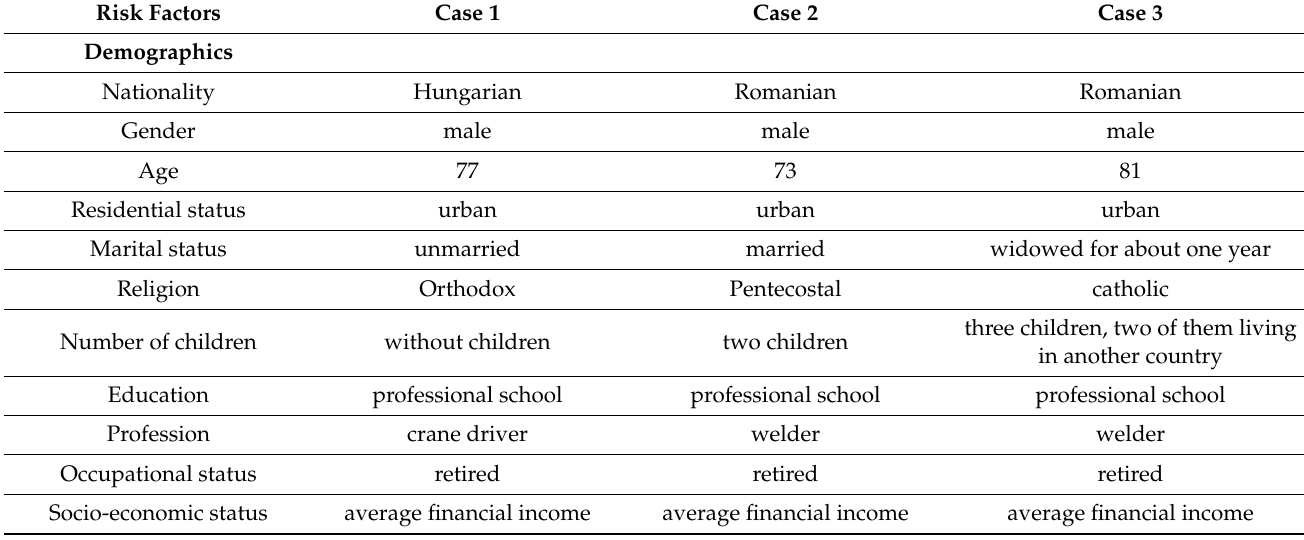
Table 1. The risk factors categories: demographics, medical records, and social